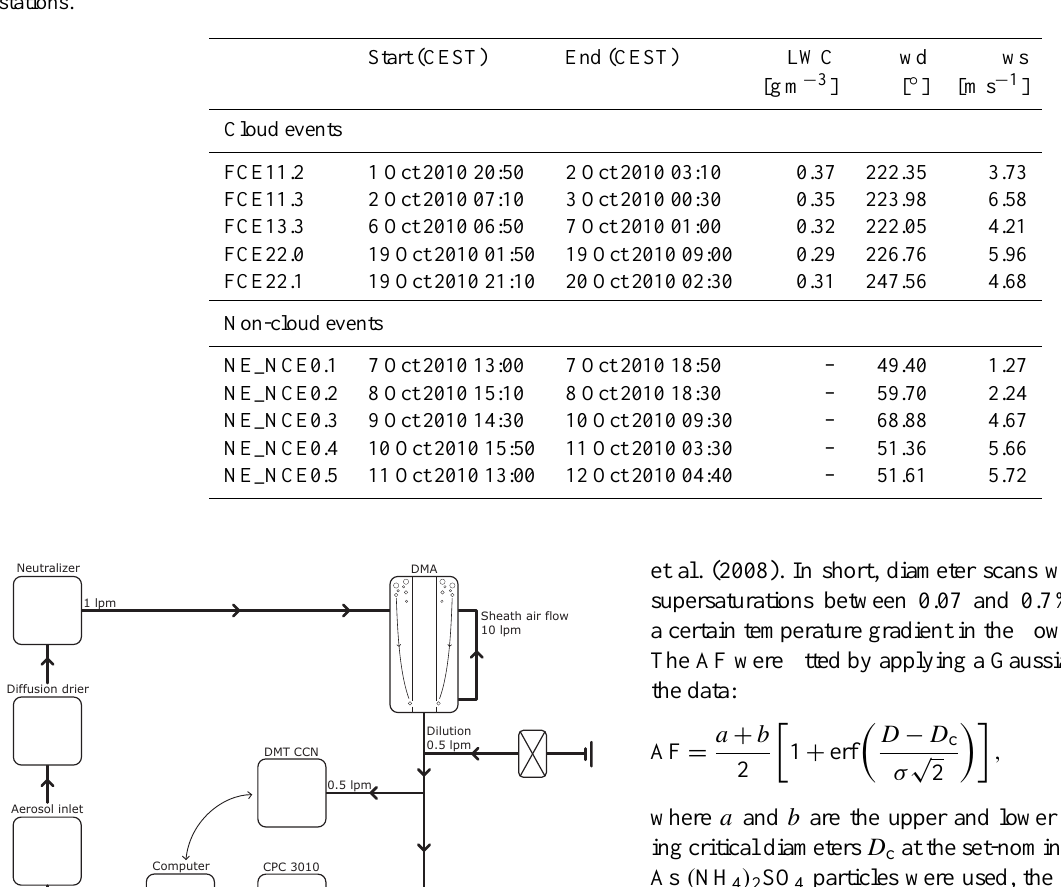
Table 1. Overview of all defined full cloud events (FCE) and non-cloud events (NE_NCE) for which CCN data are available at both valley stations.